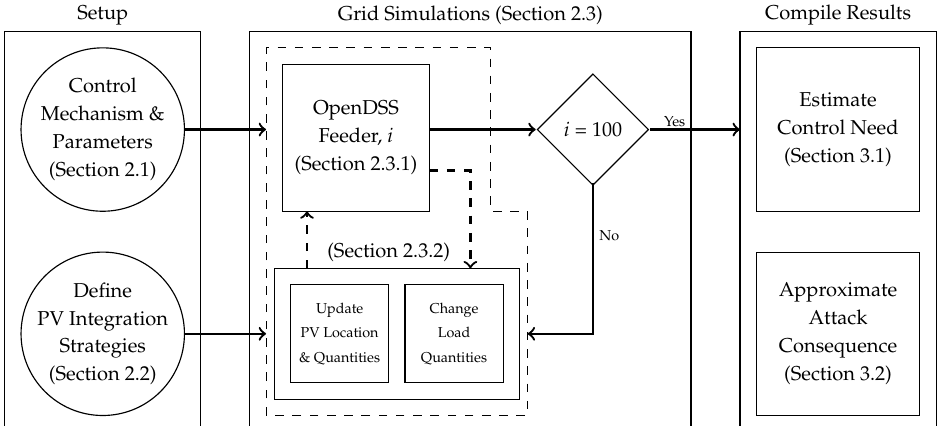
Figure 1. The experiment included three key stages: (1) setup the simulation inputs, (2) simulations, and (3) compilation of results. The setup stage involved the definition of voltage control and photovoltaic integration strategies. The simulation effort ran OpenDSS in an iterative process that updated photovoltaic and load quantities, and randomly changed the location of the distributed photovoltaic systems. Compilation of the model results determined the control needs and approximated the cyber-attack